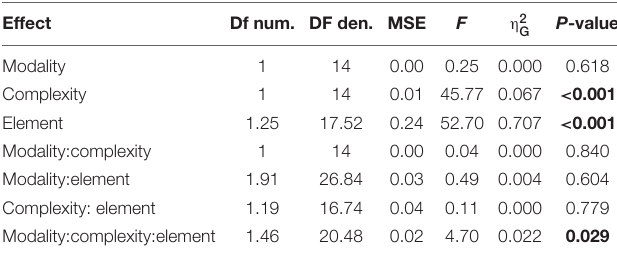
TABLE 5 | Repeated measure ANOVA—force (experiment